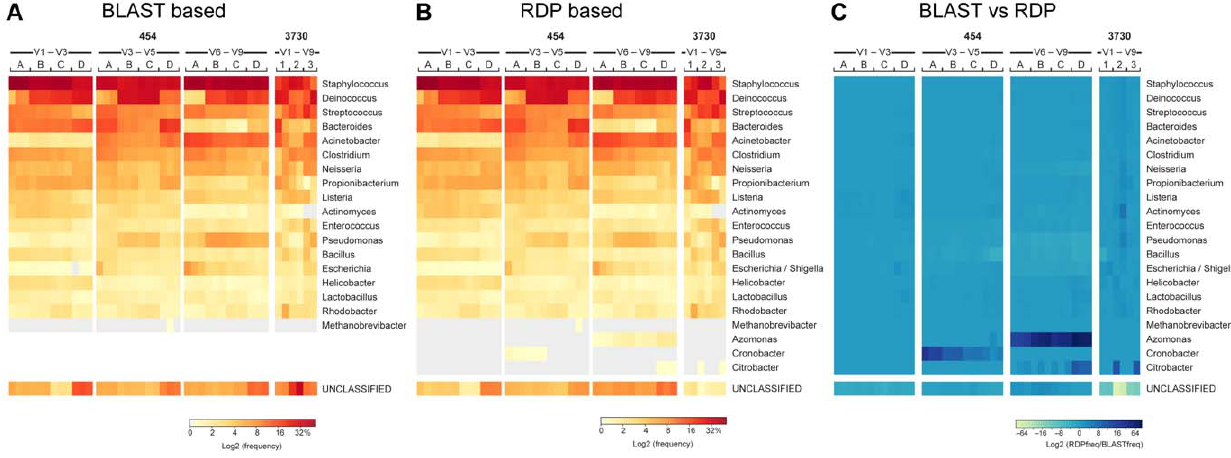
Figure 2. Minor differences in classifiability as measured by the RDP Classifier and a BLASTn-based approach . The left panel shows classification based on BLASTn against reference sequences of the MC members. A sequence is classified if it has . 95% global sequence identity with one of the reference sequences and . 90% of read is contained in the alignable region. Results are shown as a heatmap depicting the frequency values, using a binary logarithm scale. The middle heatmap illustrates frequency values of taxa identified using the RDP classification tool, applying an 80% confidence cutoff. Right panel shows the difference between RDP and BLASTn based classification, with a heatmap representing the ratio of observed genus-level frequency data (RDP) over expected genus-level frequency (BLASTn) for each of the MC members using a binary logarithm scale.